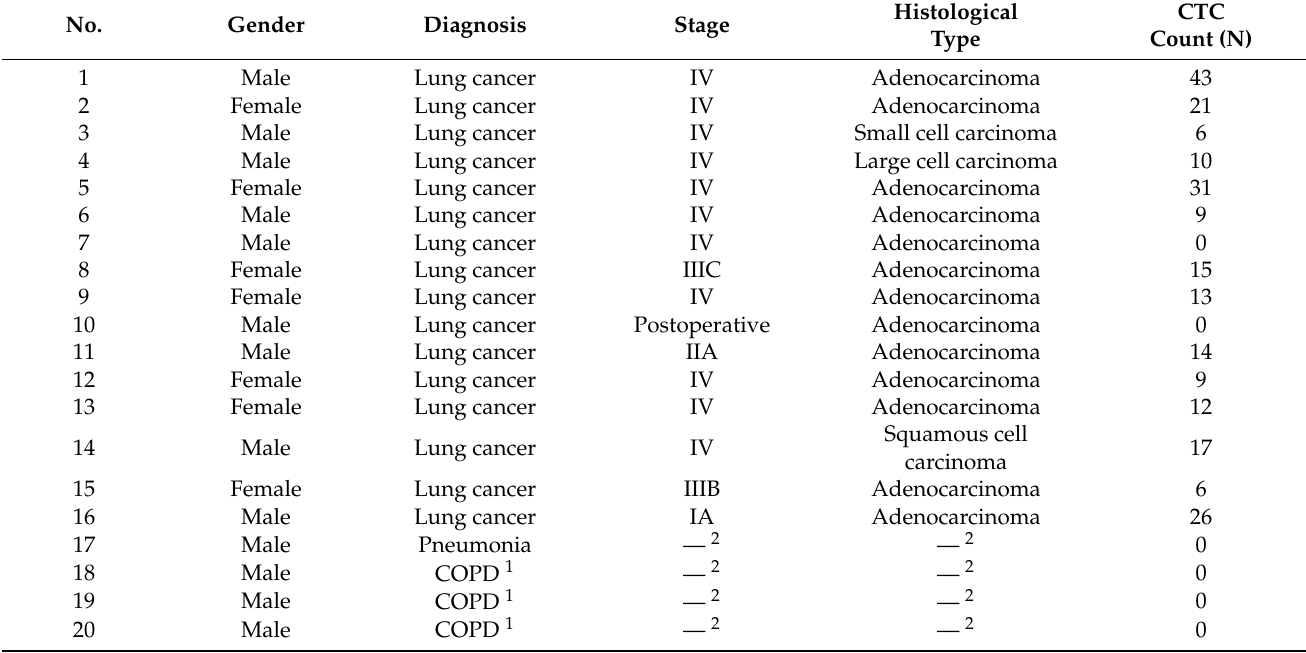
Figure 2. Capture of PC9-GFP cells by the integrated device. ( a , b ) Representative merged fluorescent field and bright images of PC9-GFP cells, white blood cells (WBCs) and CD45 dynabeads (as indicated by the arrows) after processing by the novel device ( a ) (magnification, ×200), ( b ) (magnification, ×400). ( c ) Capture rate of the integrated device at different concentrations of PC9-GFP cells. Data were expressed as mean ± standard error of mean (SEM). Table 1. Clinical characteristics of 20